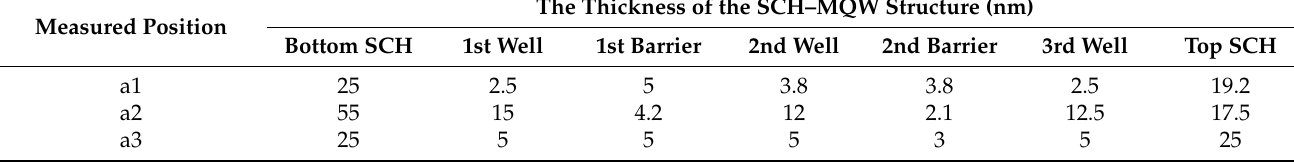
Table 1. The thickness of SCH layer, quantum well layers, and quantum barrier layers at a1, a2, and a3, marked in Figure 3b. Along the growth direction, the SCH–MQW structure is composed of the bottom SCH, 1st well, 1st barrier, 2nd well, 2nd barrier, 3rd well, and the top SCH. The Thickness of the SCH–MQW Structure (nm) Measured Position Bottom SCH 1st Well 1st Barrier 2nd Well 2nd Barrier 3rd Well